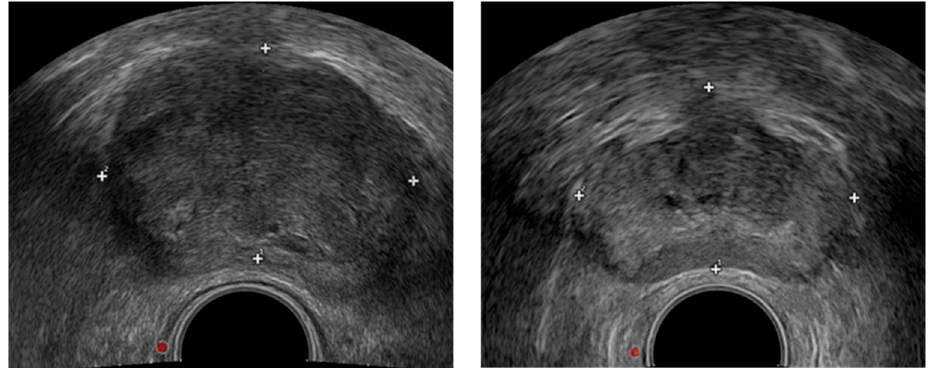
Figure 1. TRUS imaging of prostate.